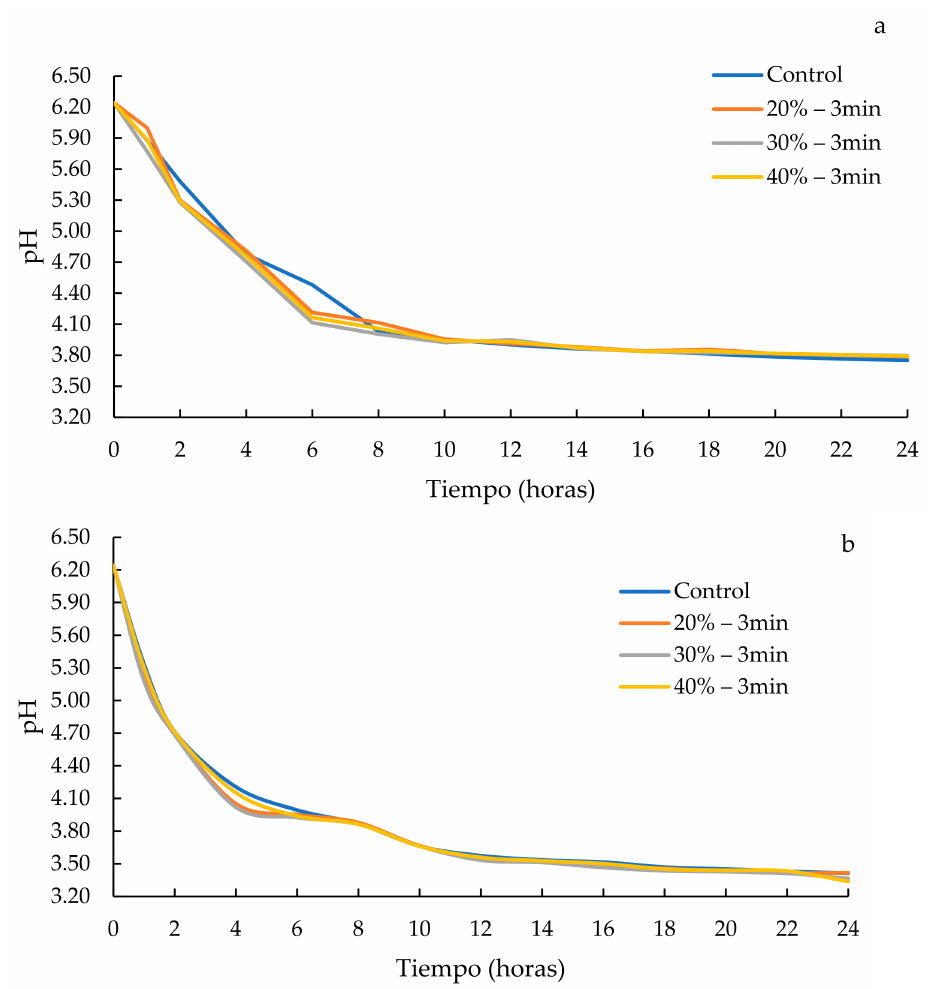
Figure 4. Effect of ultrasound (20 kHz) on the pH kinetics of L. acidophilus ( a ) and L. helveticus ( b